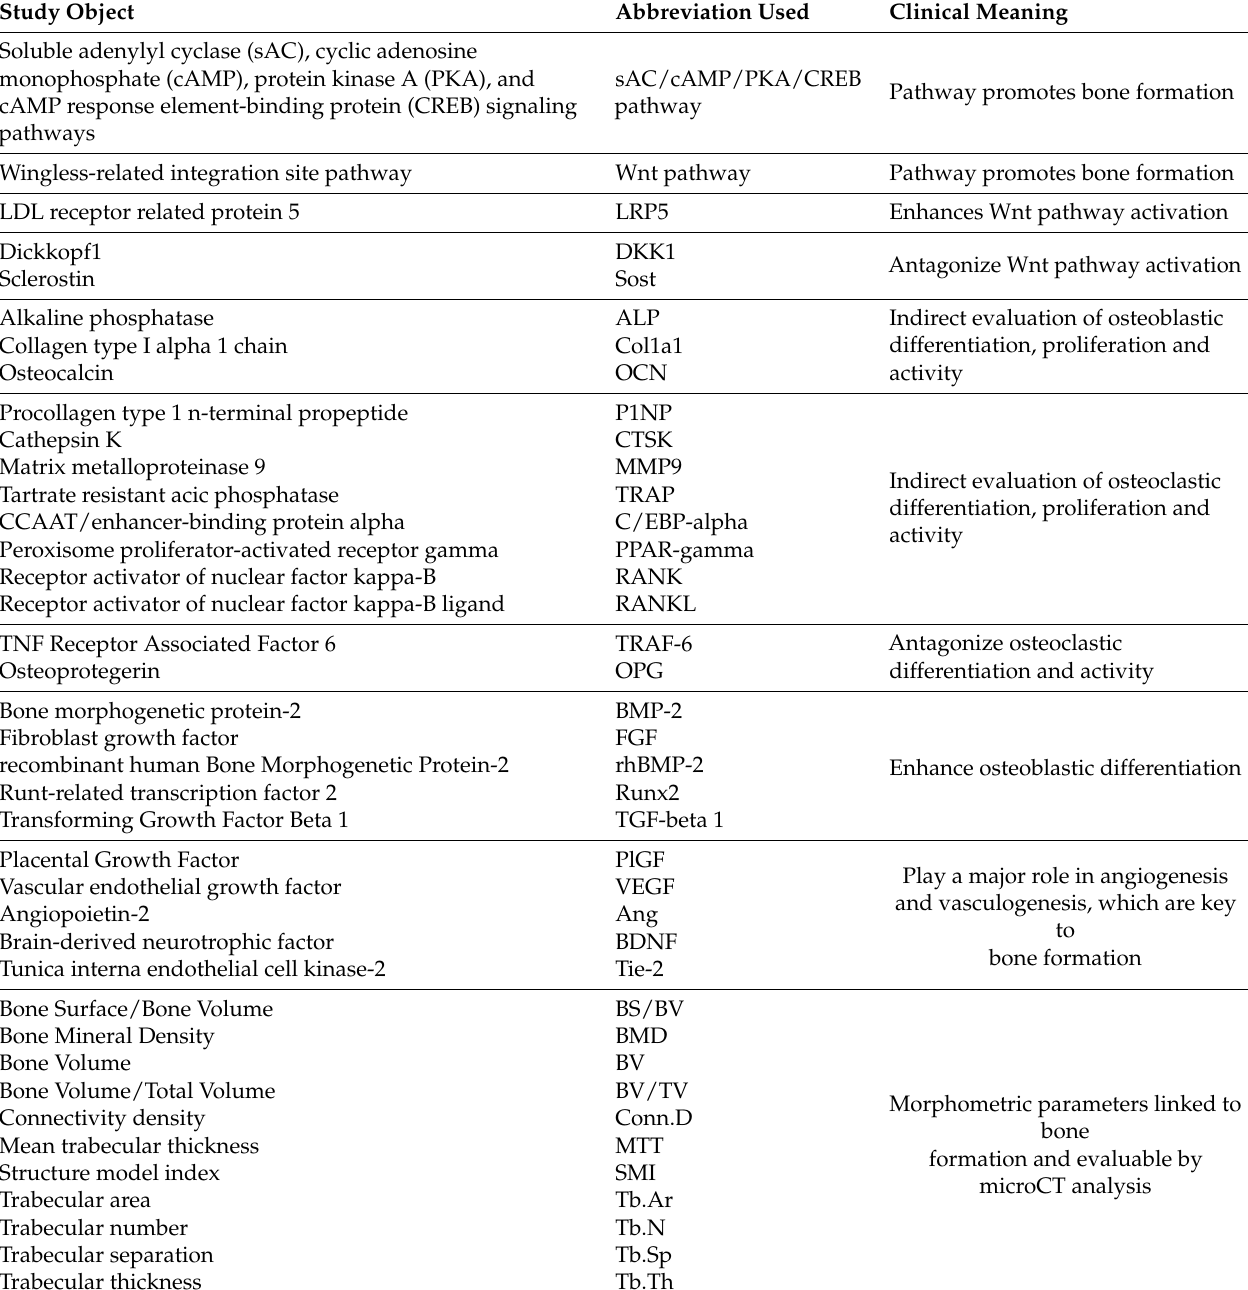
Table 1. Main features studied after PEMF